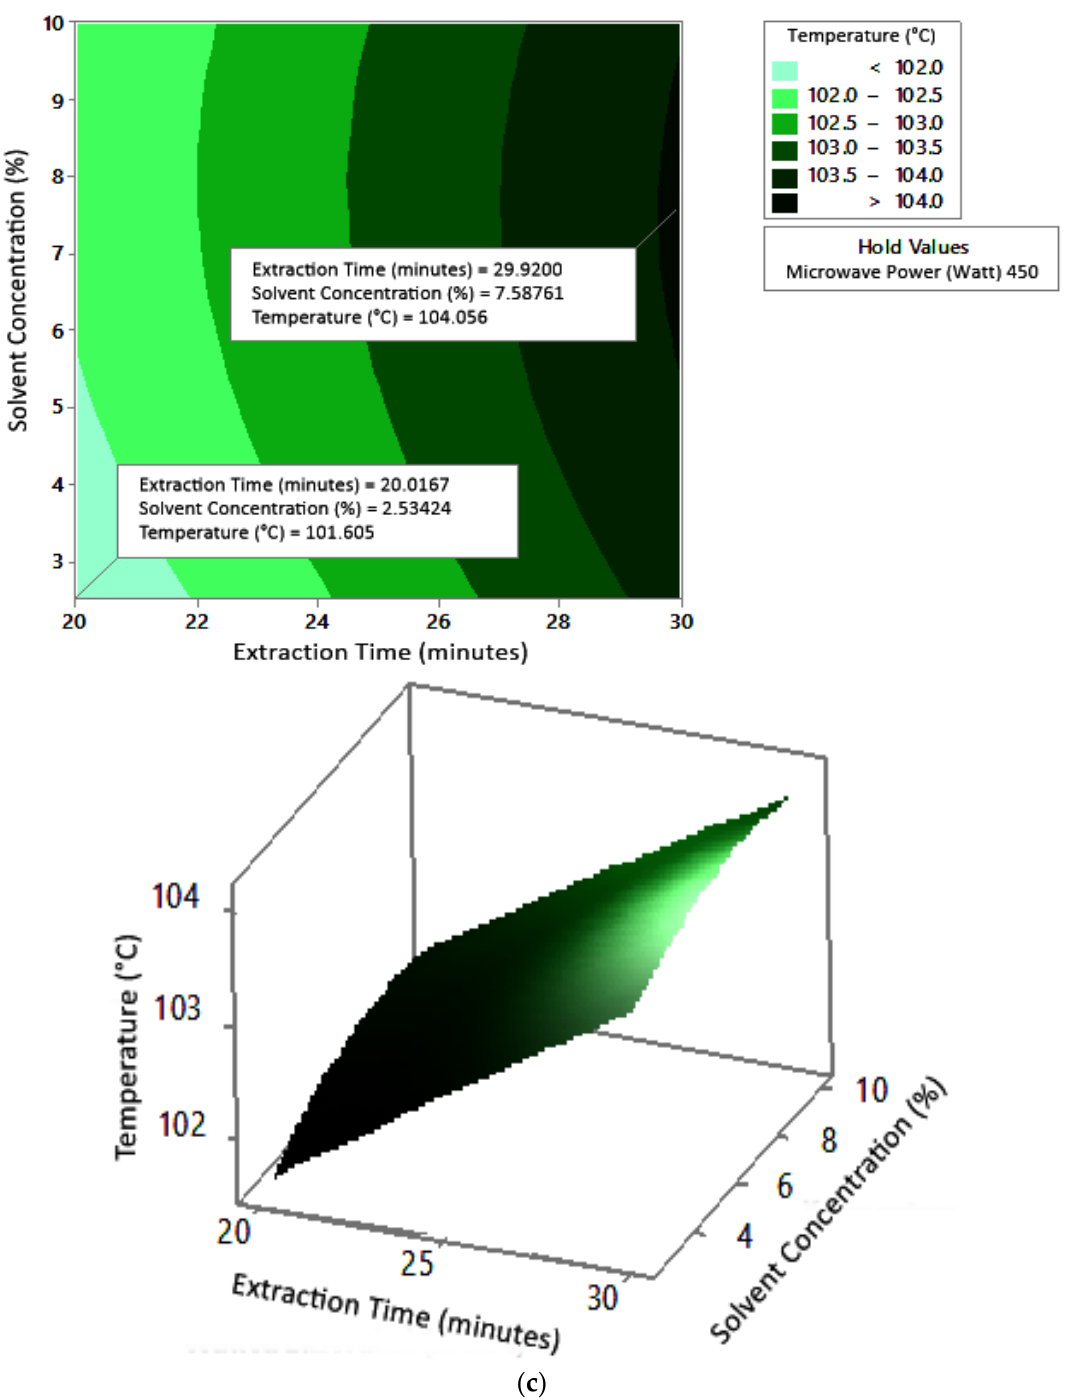
Figure 6. Effect of extraction time and solvent concentration on temperature at microwave